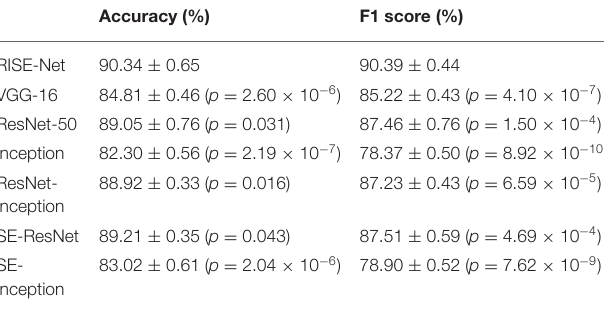
TABLE 3 | Comparison against other classification networks (mean ± stdv).